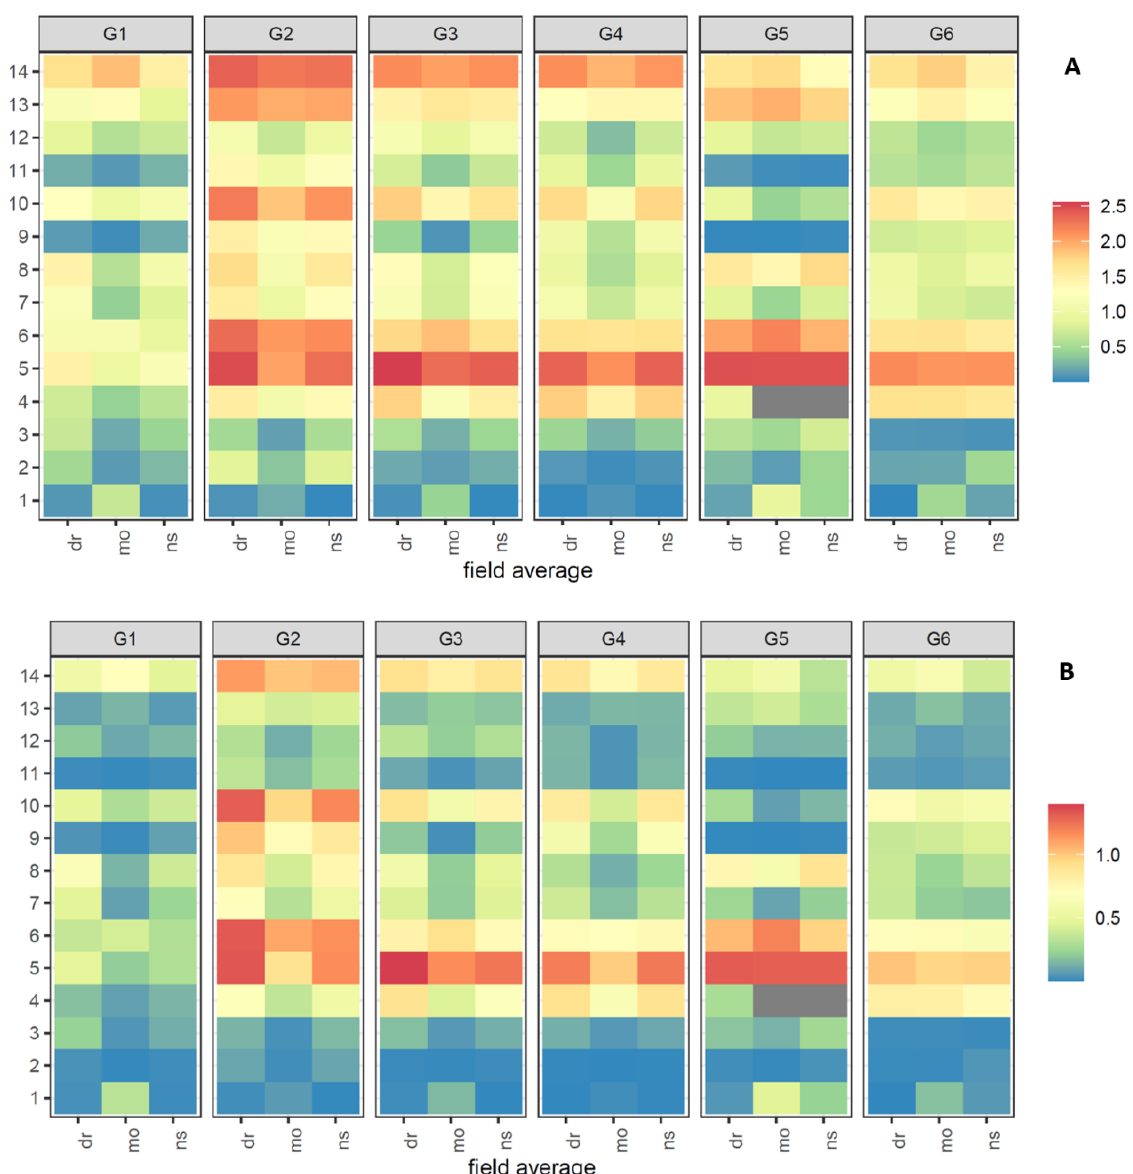
Figure 4. Heatmap presenting averaged ( A ) concentrations or ( B ) DoT-factors of metabolites 1 – 14 (as depicted in Figure 1) across three conditions of no stress (ns), waterlogging (wl), and drought stress (dr) over all fields (Figure 2).